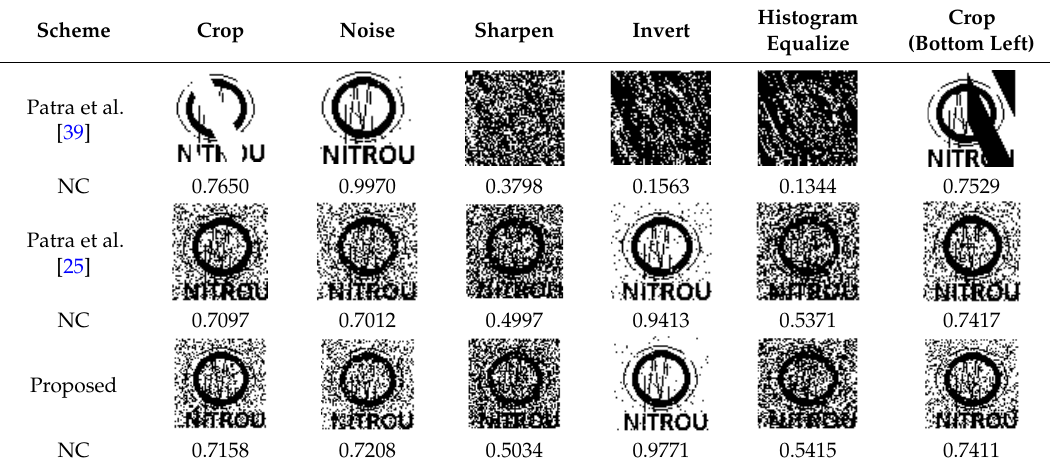
Table 5. NC comparison of extracted watermark after common